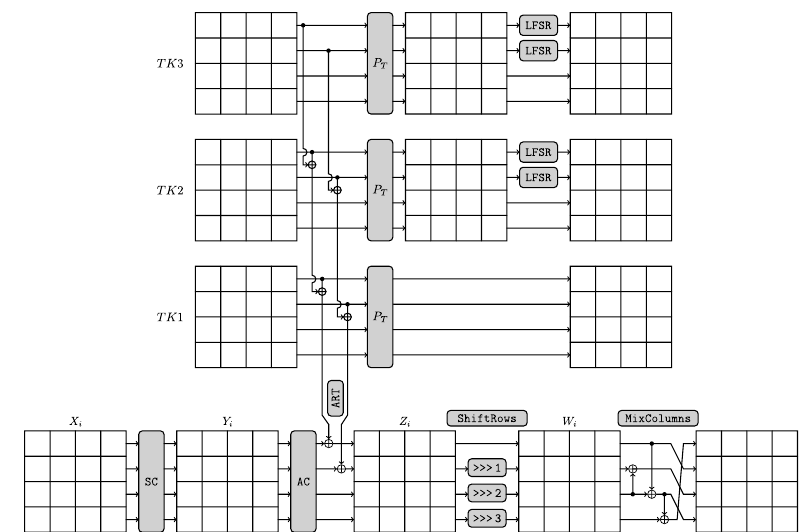
Figure 11: The round function and tweakey schedule of SKINNY